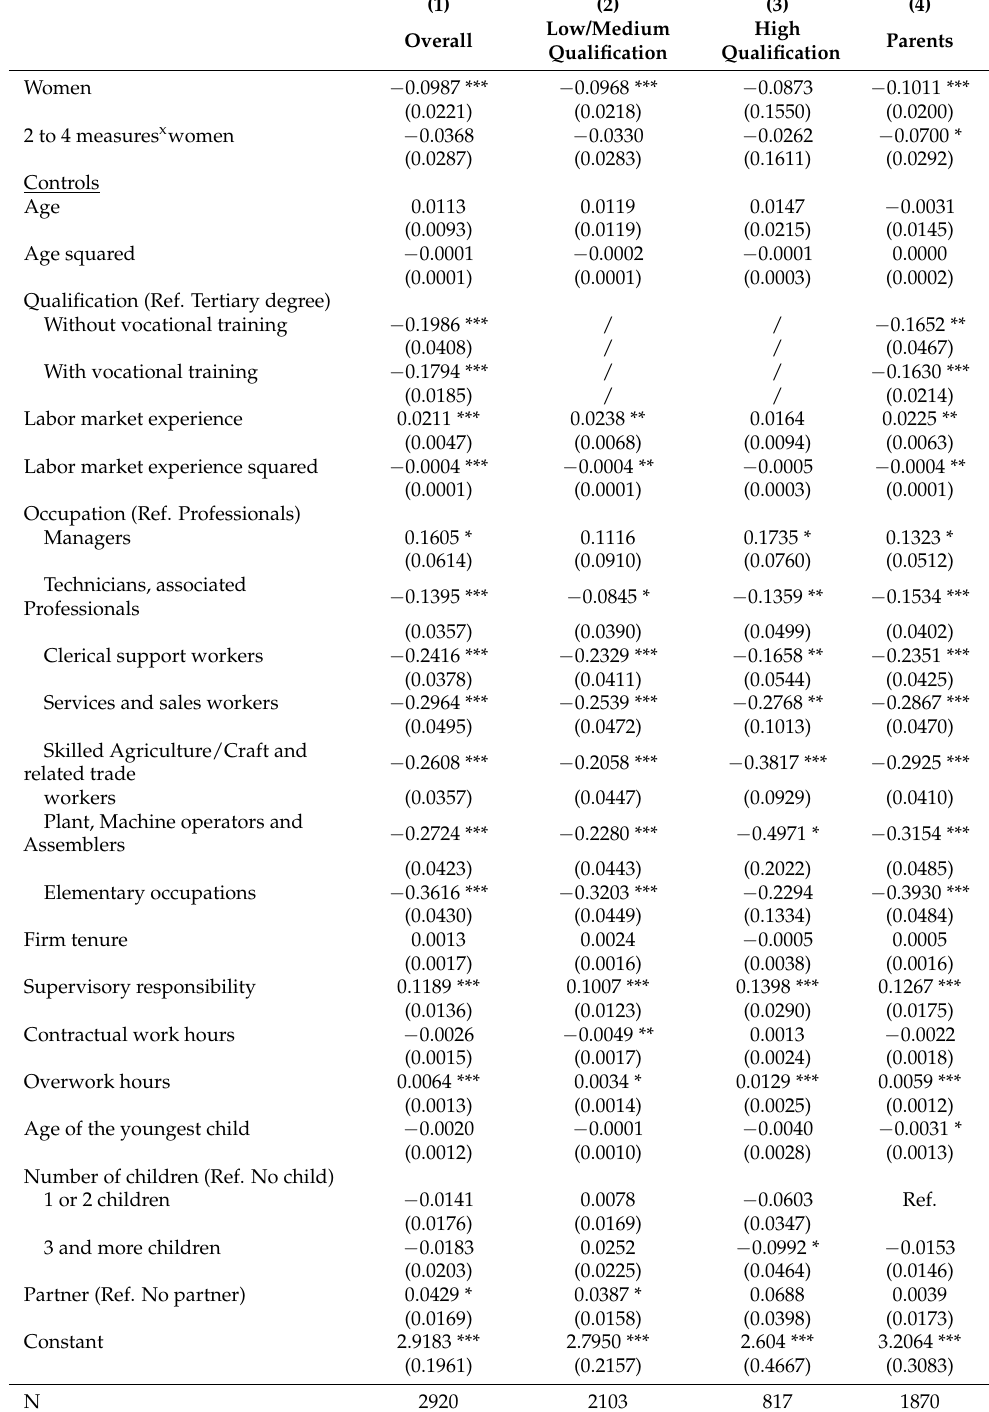
Table A10. The association of multiple WLM and log hourly wages within establishments without EQM, including control variables (extended version of Table 5, step